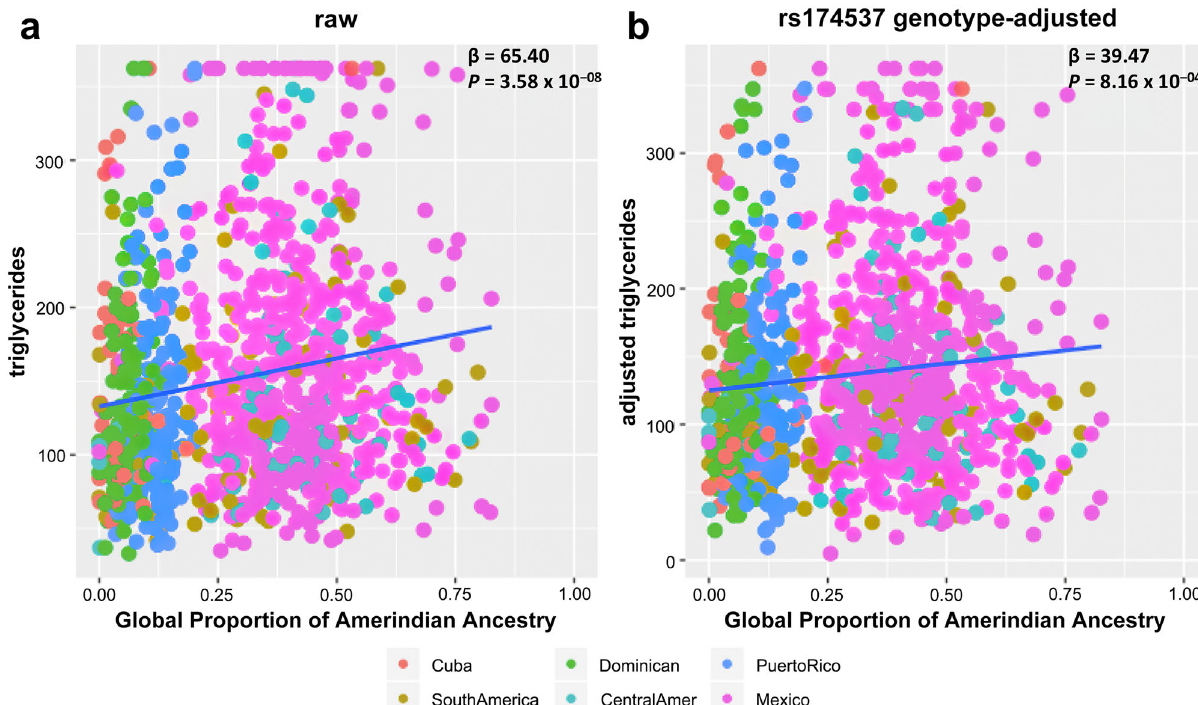
Fig. 2 Relationship of triglycerides with global proportion of Amerind ancestry before and after adjustment for rs174537 genotype. The regression effect estimates ( β in mg/dL) and P -values are shown in the upper right corner of each panel. The relationships are shown for each of a raw triglyceride levels, and b genotype-adjusted tryglyceride levels with Global Proportion of Amerind Ancestry. Here, rs174537 genotype-adjusted triglyceride levels were obtained as residuals from regression accounting for rs174537 genotype, and re-centered around the raw means. P -values are calculated using a two-sided t -test for the regression coef fi cient derived with n = 1101 biologically independent